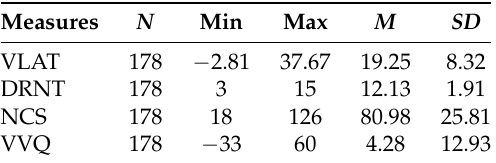
Table 1. Descriptive Statistics of Scores on the Measures.